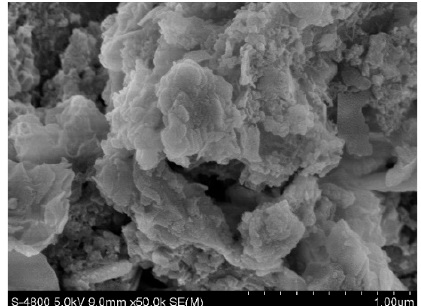
Figure 9. Magnesia matrix before treatment.